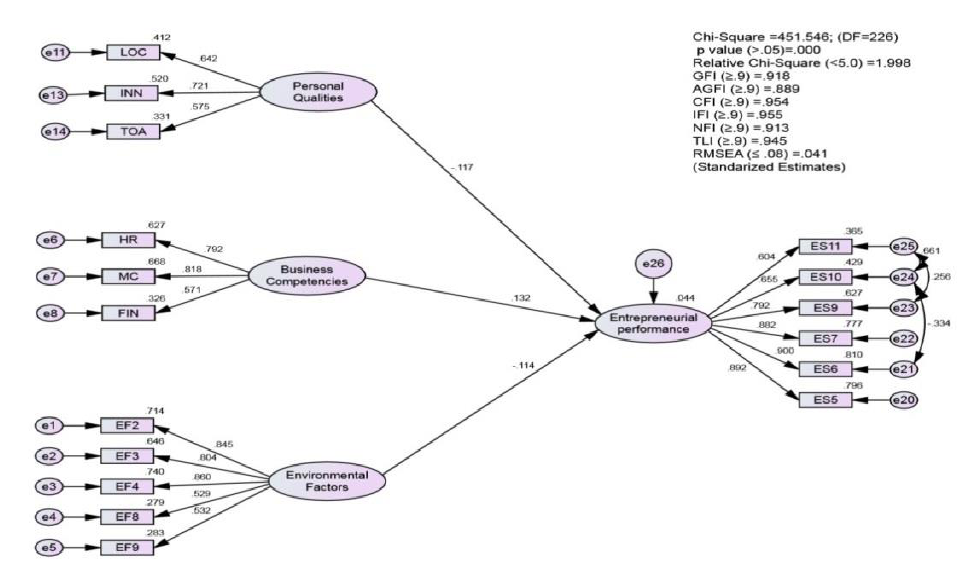
Fig. 2. The overall structural path model for group 1 (high level training transfer) Note: LOC= Locus of control; INN= Innovativeness; TOA= Tolerance of ambiguity; HR= Human resource competency; MC= Marketing competency; FIN= Financial management competency; EF= Environmental munificence factors; TOT= Training transfer; and ES= Entrepreneurial performance.